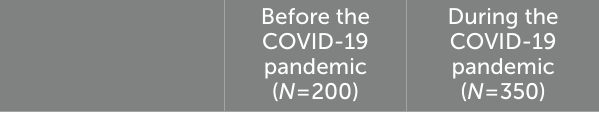
TABLE 1 Characteristics of the